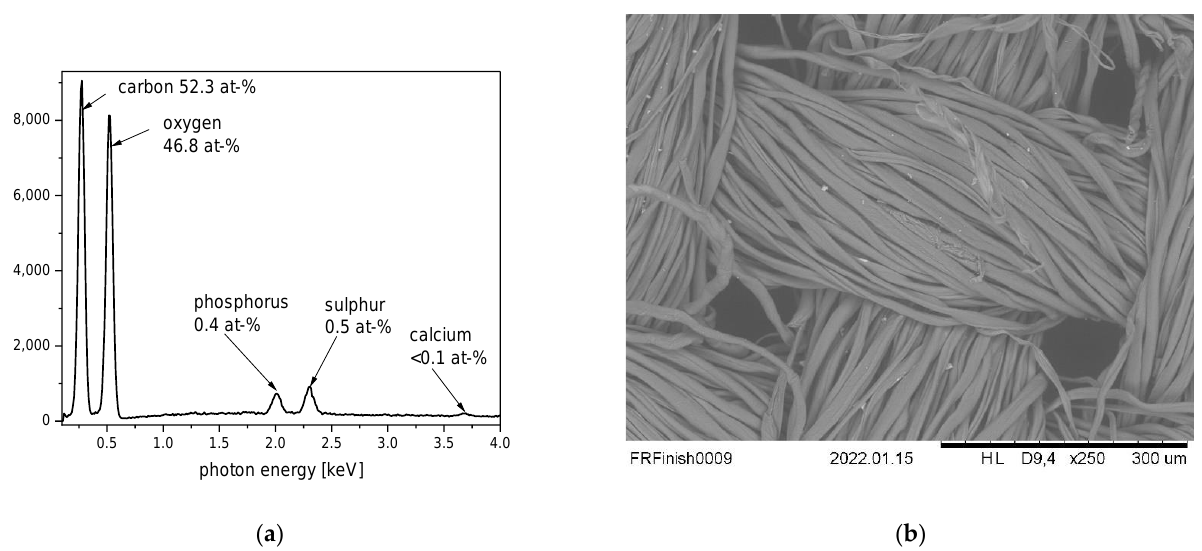
Figure 26. Cotton fabric treated with commercially available flame-retardant finishing agent (Apyrol) — ( a ) EDS spectrum; ( b ) SEM image.